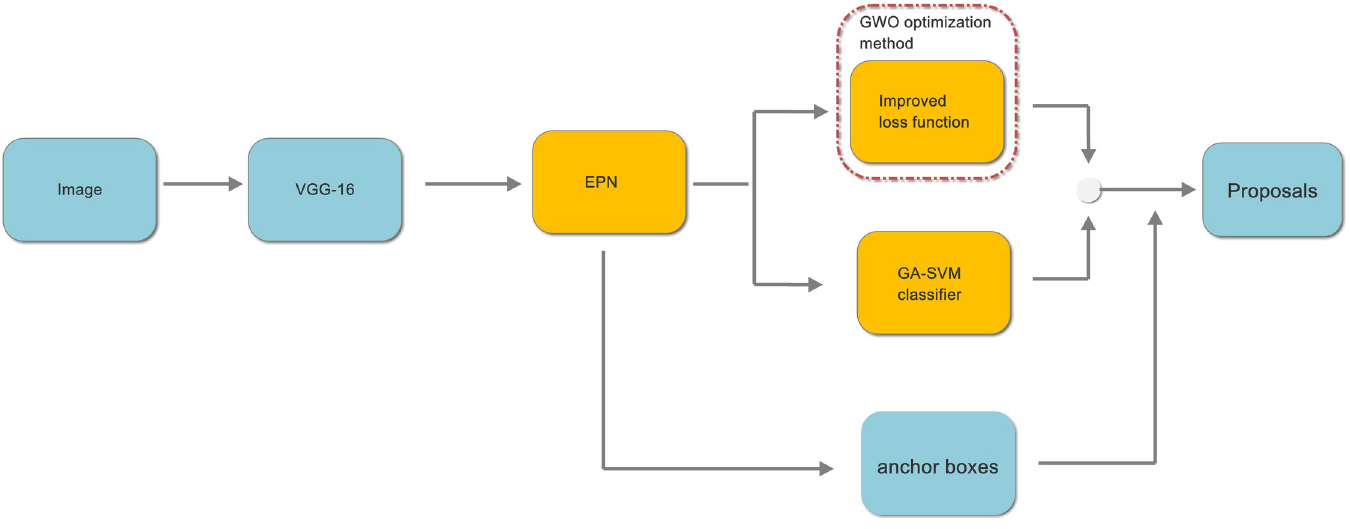
Fig 3. The general structure of